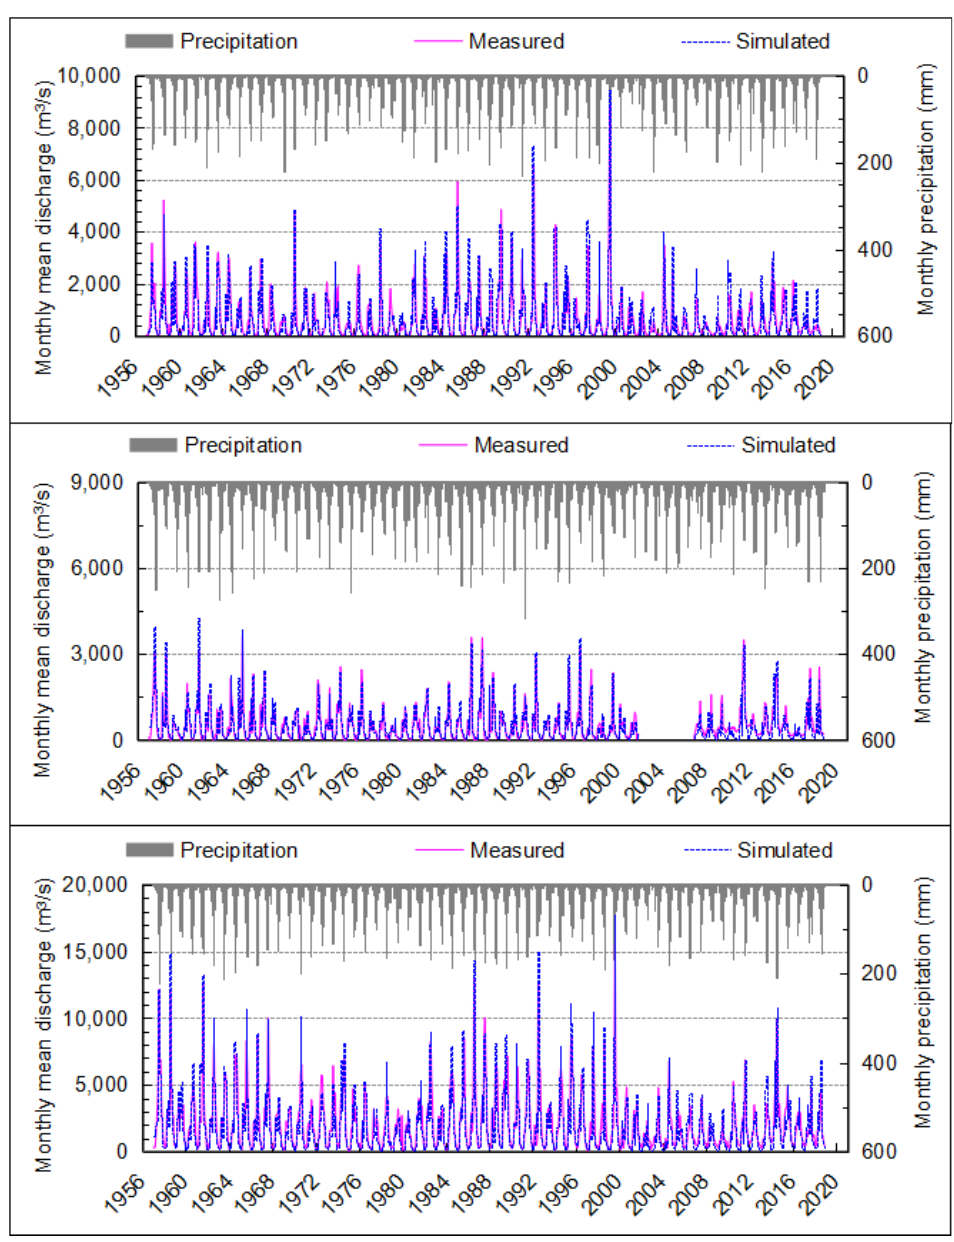
Figure 2. Validation of the WEP-N model at the Jiangqiao, Fuyu, and Jiamusi Stations. Table 1. Validation of the WEP-N model at the Jiangqiao, Fuyu, and Jiamusi Stations. N SE R E /% Hydrological Site